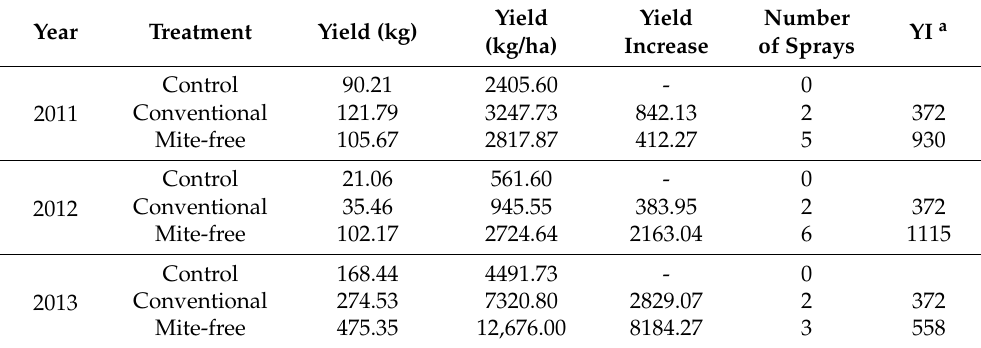
Table 10. Yields in Tenerife according to treatments and years with the number of phytosanitary sprays and the yield increase necessary to pay for those